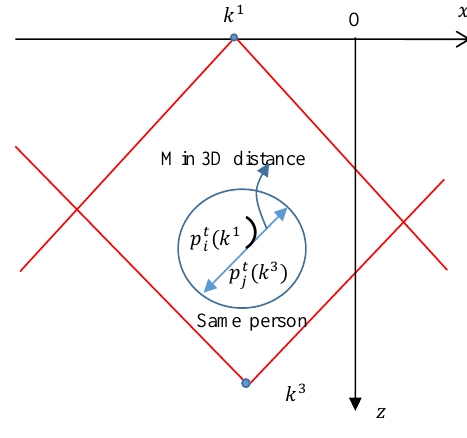
Fig. 4: Orthogonal con(cid:28)guration. Obviously, the distant threshold Td a(cid:27)ects the fusion results. If fusion rules applied for orthogo- nal con(cid:28)guration based on relative distances be- tween 3D positions are used for parallel con(cid:28)g- uration, the detected humans can be